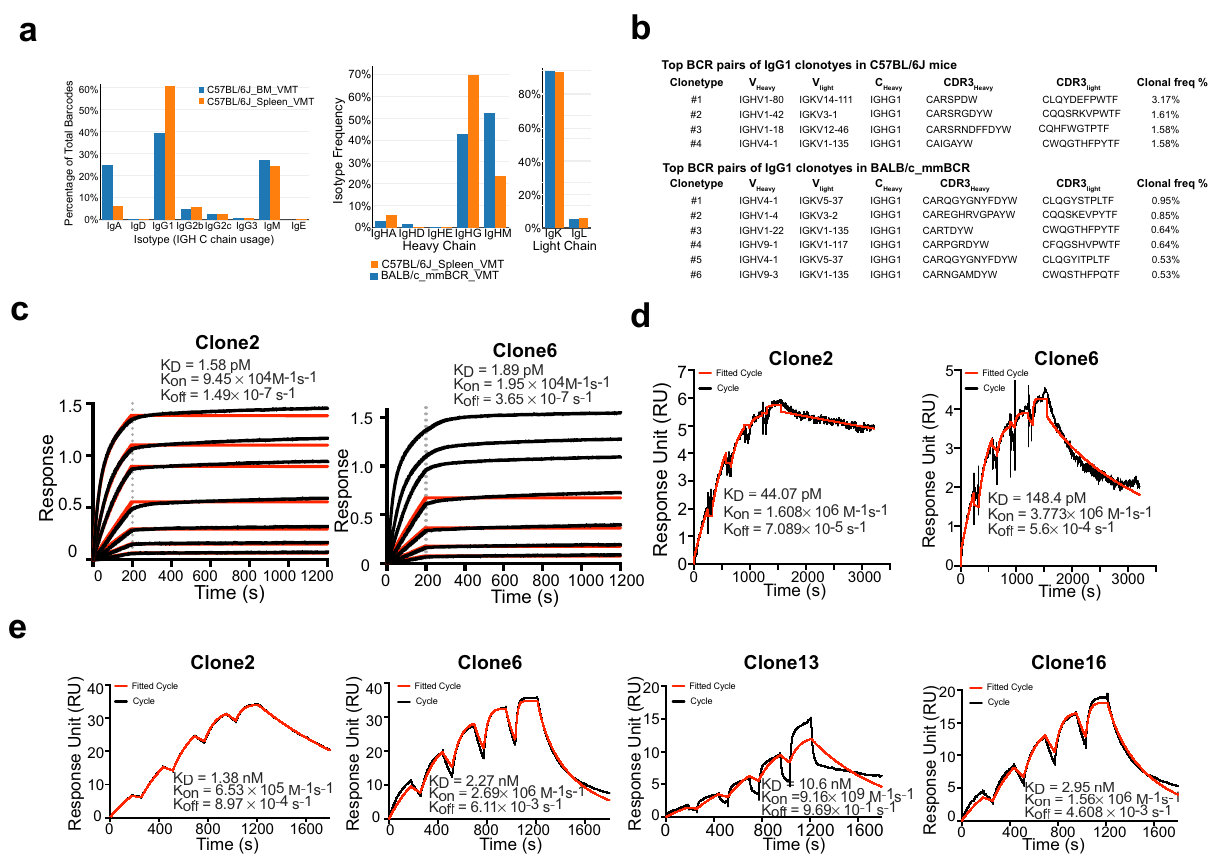
Fig. 1 Immunization-single B cell sequencing leads to development of potent monoclonal antibodies in both monospeci fi c and bispeci fi c forms. a Frequency distribution of immunoglobulin isotypes in SARS-CoV-2 Spike RBD (receptor-binding domain) immunized mice. (Top) Analysis of isotypes in both bone marrow and spleen in RBD-immunized C57BL/6 J mice ( n = 1 mouse) (Bottom) Analysis of isotypes in RBD-immunized C57BL/6J and BALB/c mice ( n = 1 mouse). b CDR3 sequences of heavy and light chains of the top enriched antibody clones from RBD-his tag immunized C57BL/6 J mice (Top) and BALB/c mice (Bottom). CDR3: Complementarity-determining regions 3. c Octet measurement of binding strengths top SARS-CoV-2 RBD-speci fi c monospeci fi c mAb clones (Clones 2 and 6). The binding was particularly strong, thus that the dissociation stage was never observed in this BLI assay. d SPR measurement of binding strengths top SARS-CoV-2 RBD-speci fi c monospeci fi c mAb clones (Clones 2 and 6), using an NTA chip where the antigen (RBD) was fi xed on the chip. e SPR measurement of binding strengths top SARS-CoV-2 RBD-speci fi c monospeci fi c mAb clones (Clones 2 and 6), a humanized mAb clone (Clone 13), and a bispeci fi c mAb (Clone 16), using an Fc chip where antibodies were fi xed on the chip. Source data and additional statistics for experiments are provided as a Source Data fi